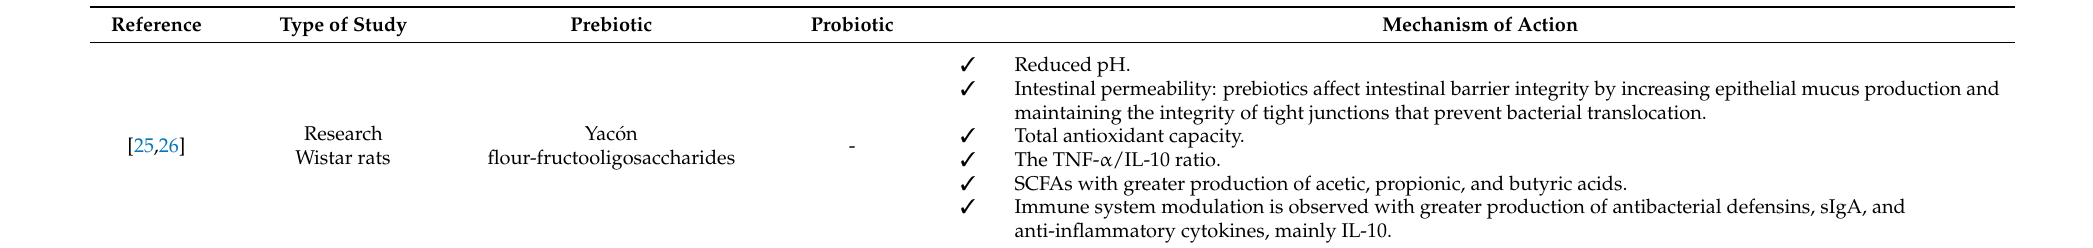
Table 2. Prevention of Colorectal cancer (CRC) using various prebiotics in